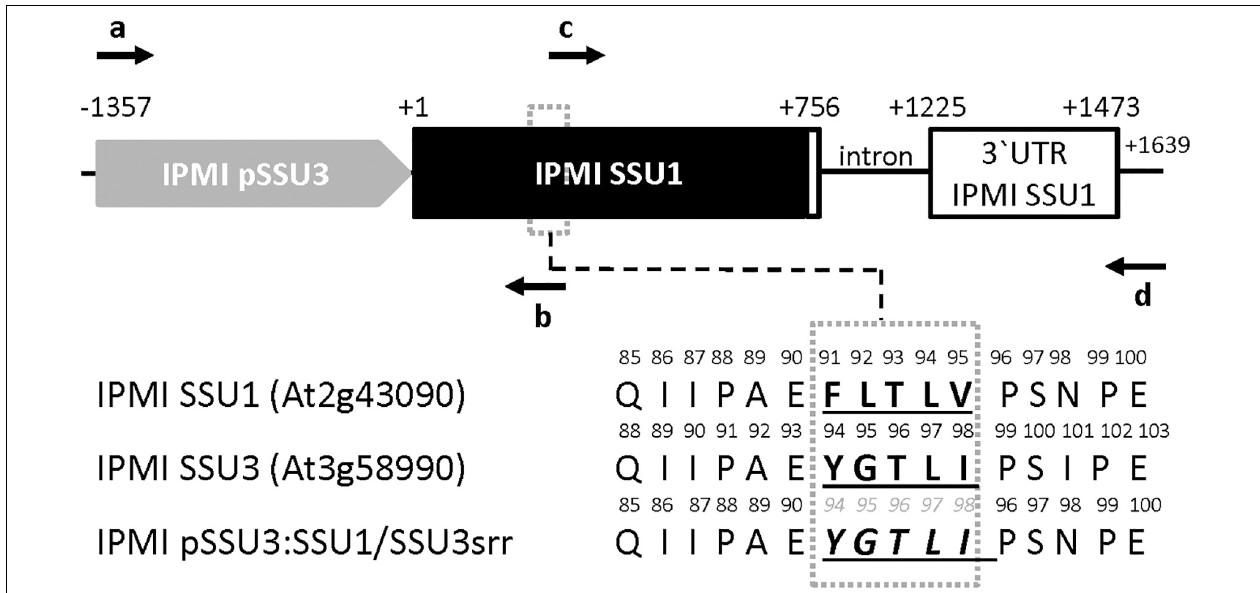
FIGURE 2 | Schema of the construct used to test the importance of distinct amino acids in the substrate recognition region (SRR) in the small subunits of IPMI. The IPMI SSU1 reading frame (black box) including its native 3 (cid:48) untranslated region (3 (cid:48) UTR), white box) is expressed under the control of the IPMI SSU3 promoter (gray box). In the SRR (dotted box) three amino acids originally present in IPMI SSU1 were substituted by the corresponding amino acid present in IPMI SSU3. Original amino acid sequences and the resulting new sequence (IPMI pSSU3:SSU1/SSU3srr) are given in the lower part of the figure. Oligonucleotides used for the generation of the construct and the amino acid replacement are indicated as horizontal arrows. Theses primers are: a, ssu3comp.H; b, SSU3/1FOE.R2, c, SSU1FOE.H and d, SSU1comp.R. Oligonucleotide sequences are given in Supplementary Table S2 . Numbering is given with respect to the translation start codons. Schema not drawn to